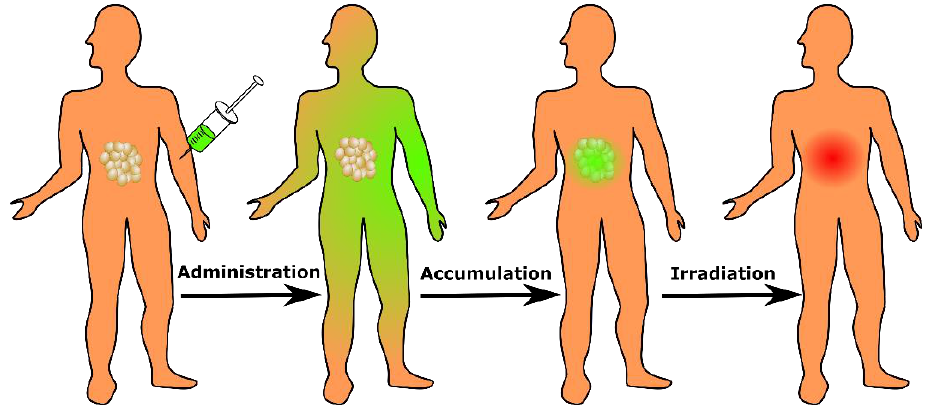
Figure 1. PDT workflow schematic. Following PS administration, there is a delay period during which the PS accumulates in malignant tissue, followed by light activation at the target site.